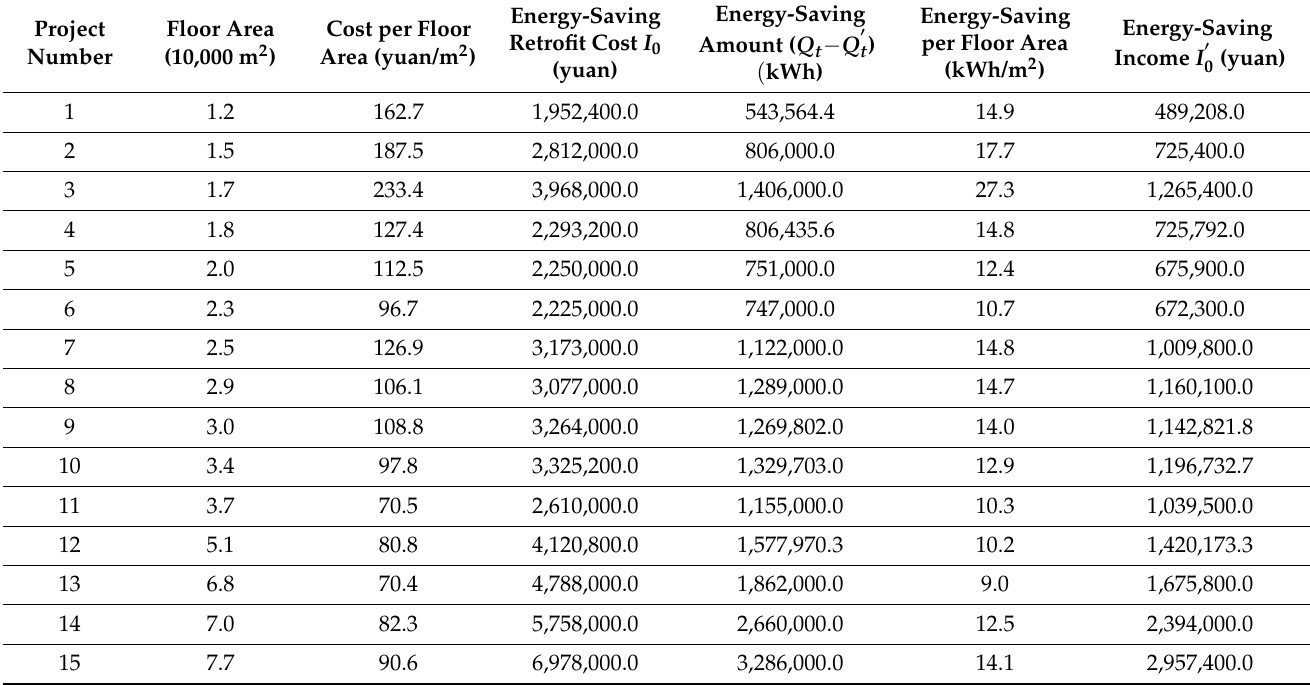
Table 3. Economic indicators of energy-saving retrofit of existing